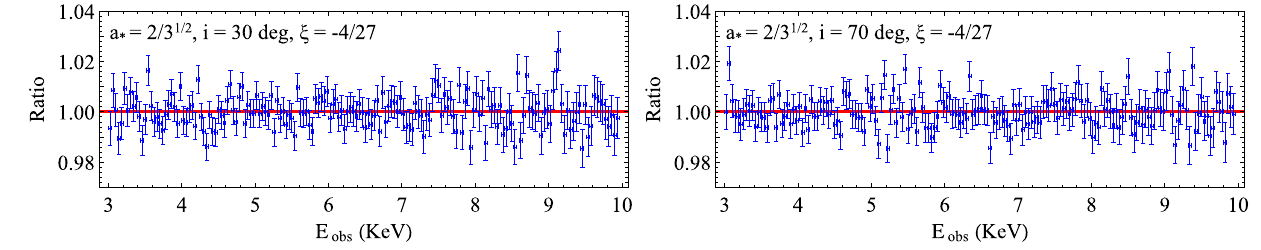
Fig. 6 Ratio data/best-fit model for simulations 12 and 13. See the text for more